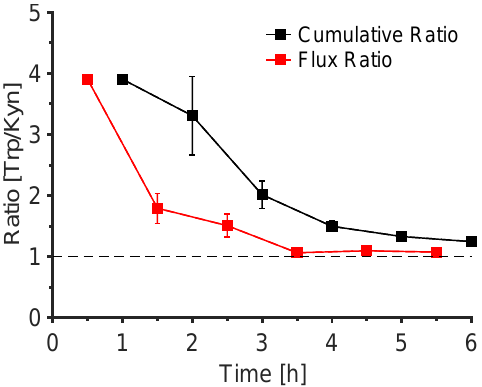
Figure 6. Trp/Kyn ratios of the cumulative amounts extracted (black) and the corresponding fluxes (red) to the cathode as a function of time when the receiver medium was an aqueous pH 7.4 buffer. Data are presented as mean ± SEM ( n = 1 for the first hour, n = 4 for the second hour, and n = 6 thereafter).